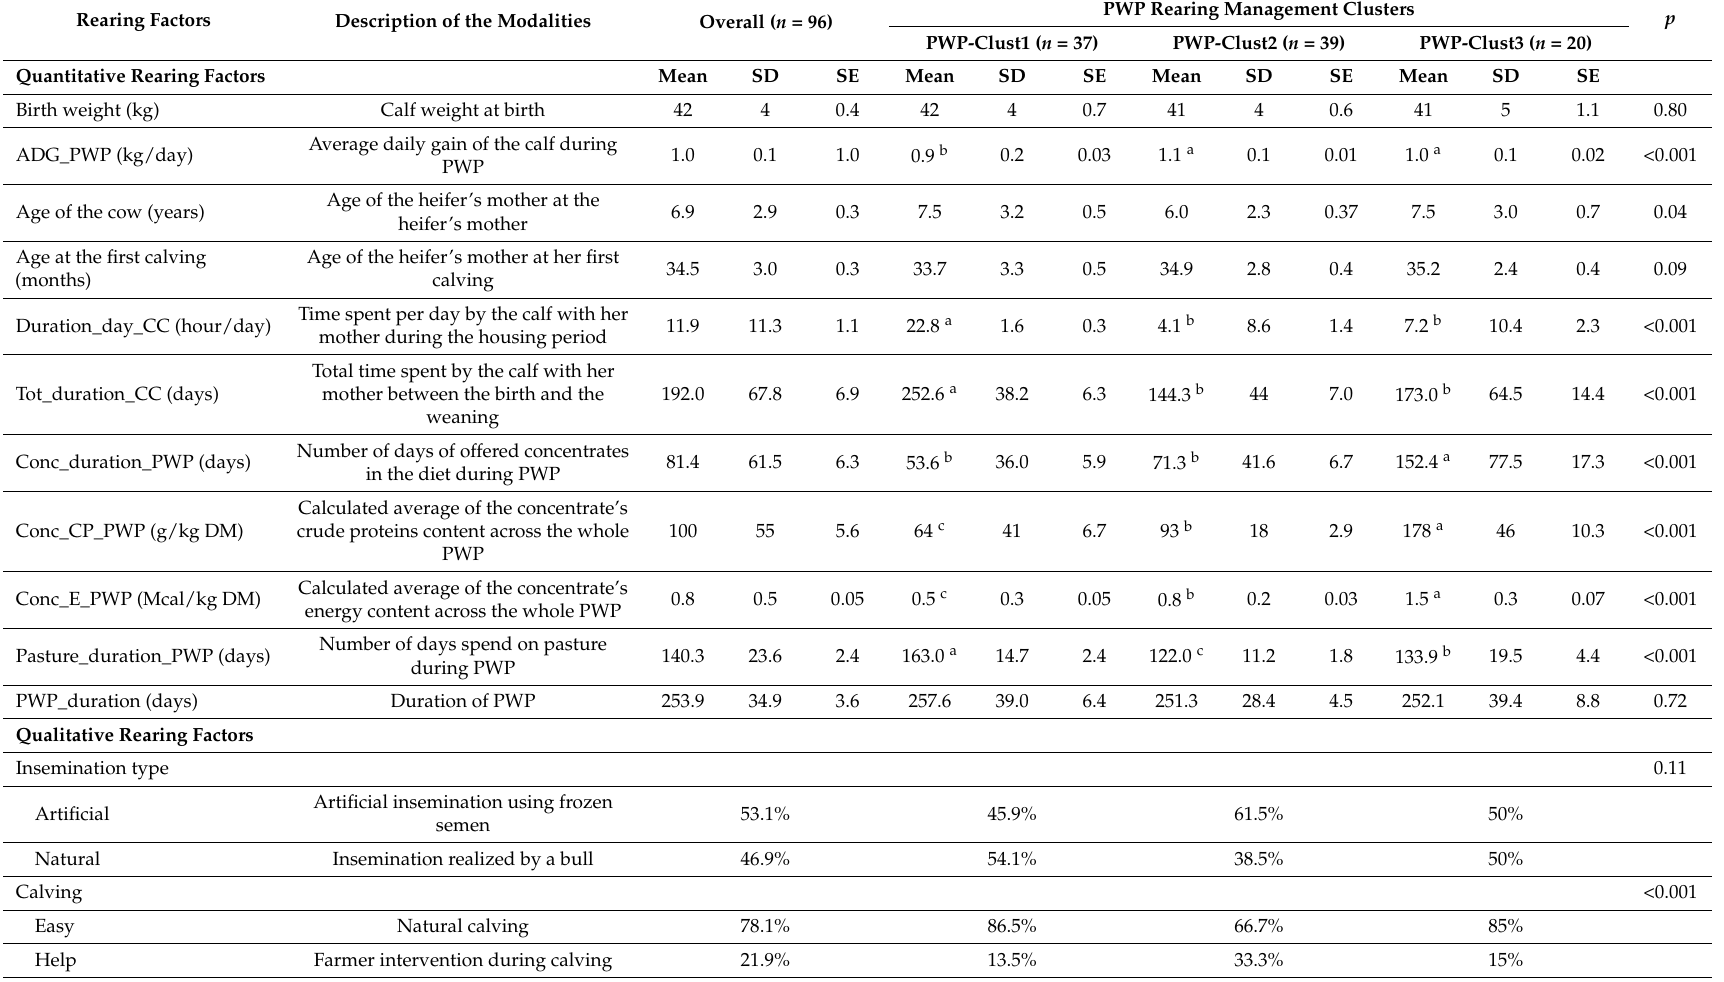
Table 1. Description of the rearing factors characterizing the pre-weaning period (PWP) and the PWP rearing management clusters obtained for this period